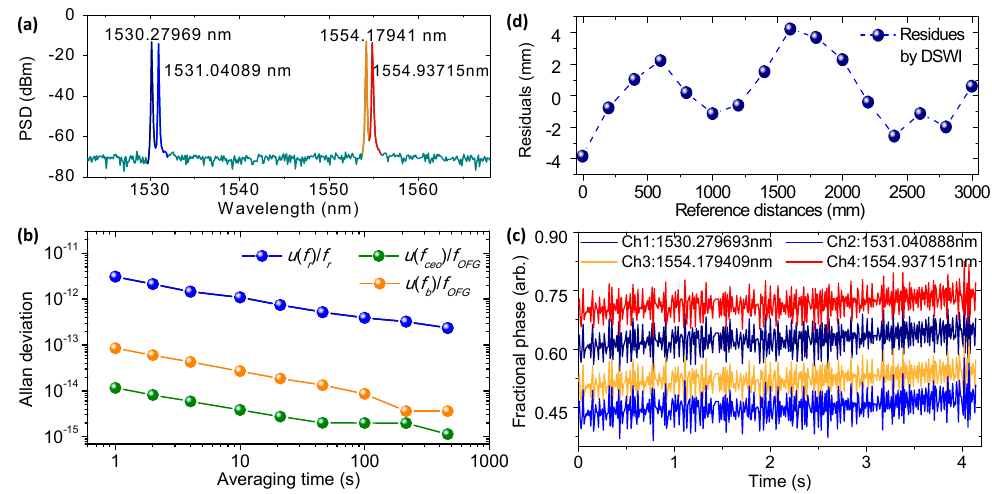
Figure 5. Test results for preparation of real-time and meter-scale absolute distance measurement. ( a ) Parallel generated four wavelengths for MWI. ( b ) Frequency stability evaluation. ( c ) Simultaneously detected phases for MWI in real time. ( d ) Comparative residual distances between DSWI and He–Ne laser interferometer.